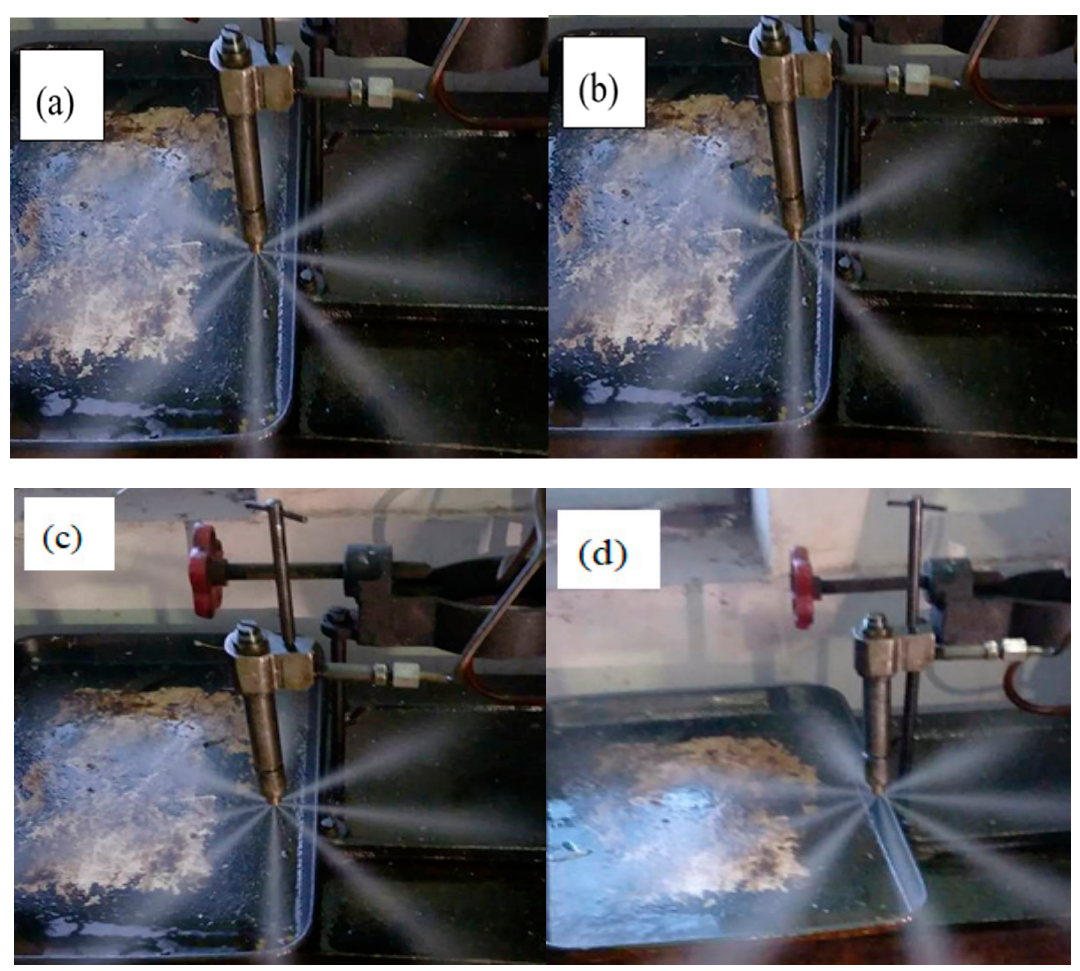
Figure 8. Atomization properties tests of ( a ) 0# diesel oil (oil sample 1); ( b ) 0# diesel oil (oil sample 1) with 0.03 wt % graphene additives; ( c ) 0# diesel oil (oil sample 2); ( d ) 0# diesel oil (oil sample 2) with 0.03 wt % graphene additives.